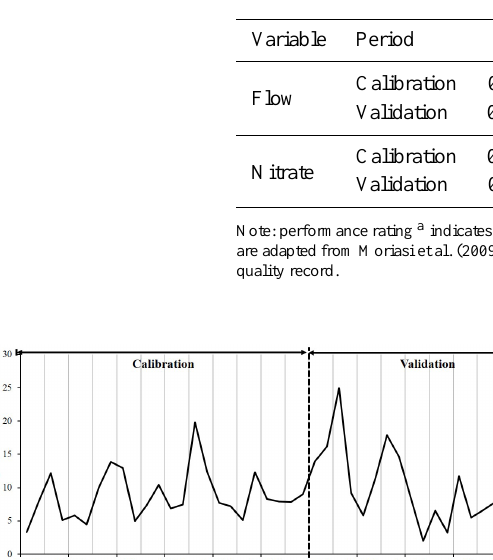
Table 5. Model performance measures for streamflow and nitrate.